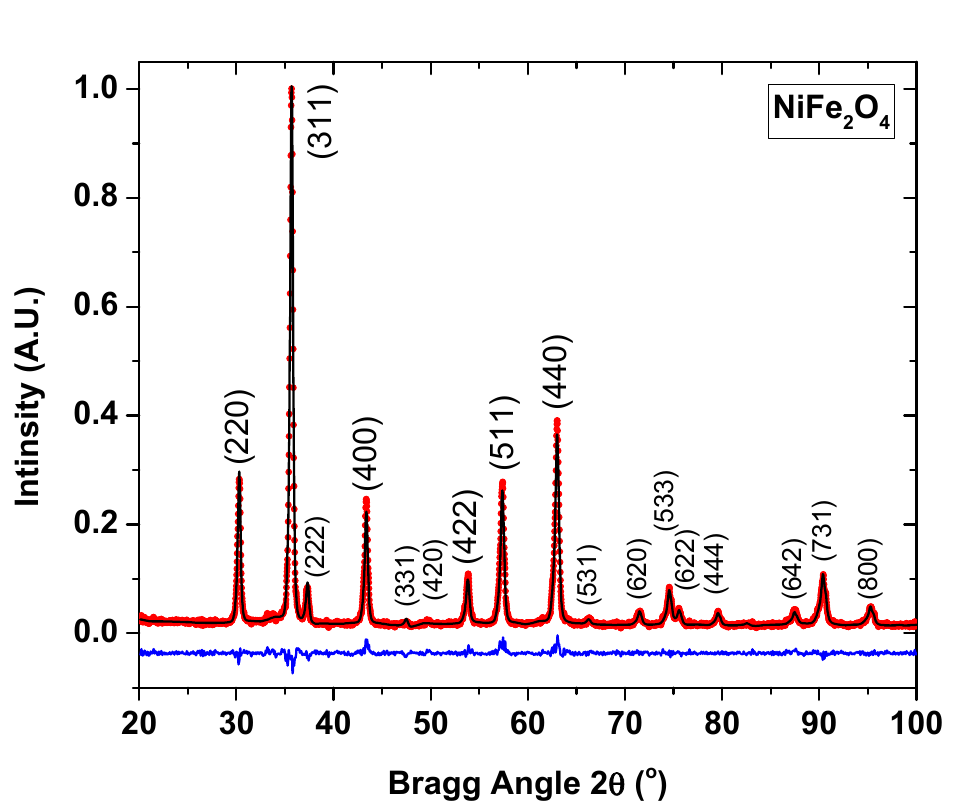
Figure 1. Rietveld refinement of the X-ray diffraction pattern of NiFe 2 O 4